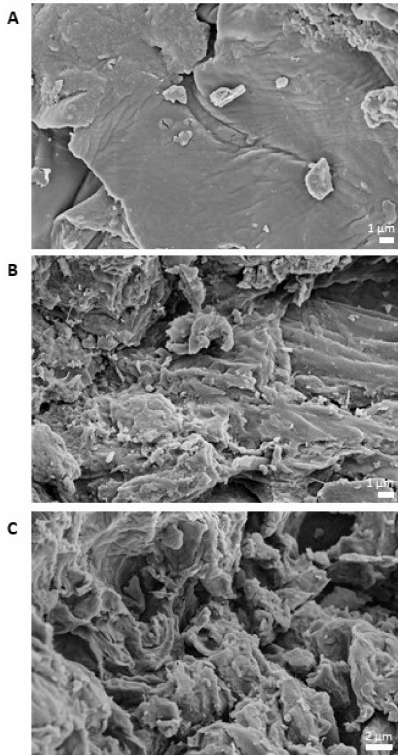
Figure 5. Scanning electron microscope images of conventional apple pomace surfaces. ( A ) Raw mate- rial. ( B ) Extruded, screw speed: 200 min − 1 , screw configuration S1, barrel temperature: 120 ◦ C, water content: 22%. ( C ) Extruded, screw speed: 200 min − 1 , screw configuration S4, barrel temperature: 120 ◦ C, water content: